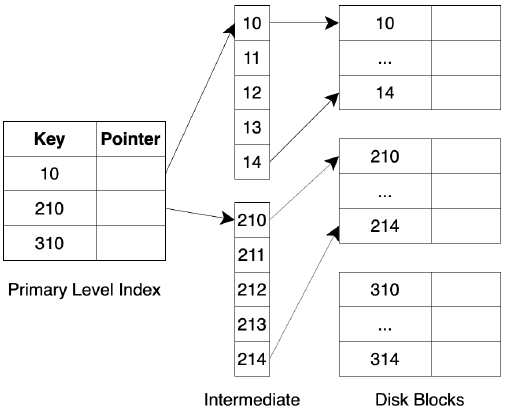
Figure 2. Secondary index. The secondary Index can be generated by a field which has a unique value for each record, and it should be a candidate key. It is also known as a non-clustering